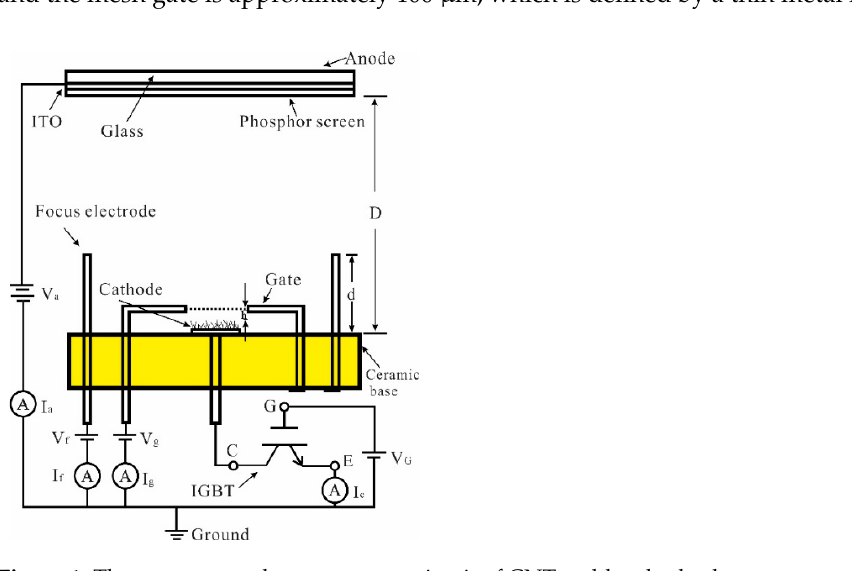
Figure 2. SEM images of the prepared CNTs. ( a , b ) The overview morphology under different magnifications. ( c ) The cross-sectional view of grown CNTs. ( d ) SEM image of one protruding CNT.